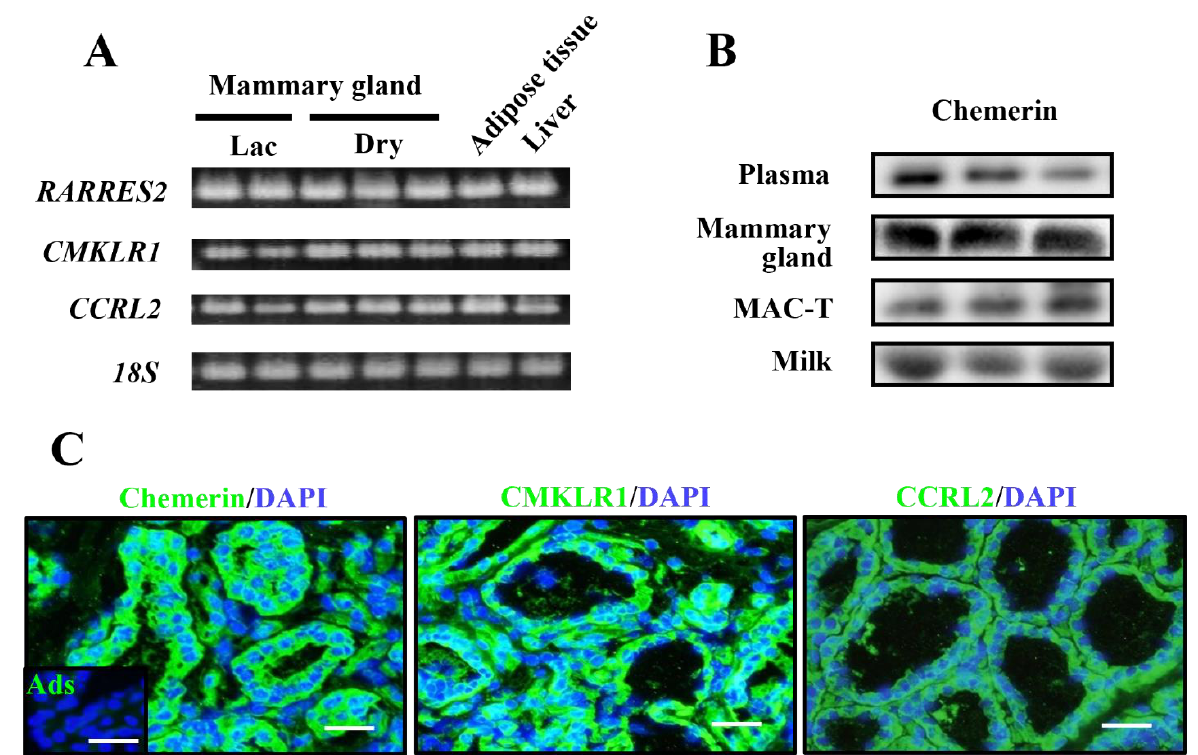
Figure 1. Expression and localization of chemerin and its receptors in the bovine mammary gland. Mammary gland tissues were collected from multiparous Holstein dairy cows at the lactation (Lac) and dry-off periods (Dry); n = 2 and 3, respectively. Gene expression of chemerin and its receptors were investigated by RT-PCR, whereas perirenal adipose tissue and the liver served as positive controls ( A ). Chemerin protein (approximately 18 kDa) was detected by immunoblotting in plasma and fresh milk from other lactating Holstein cows ( n = 3) ( B ). Chemerin or its receptor-expressing cells were visualized by immunostaining in frozen mammary gland sections from lactating Holstein cows; n = 3 ( C ). Control sections were treated with antigen-adsorbed anti-chemerin antibodies for immunostaining (Ads). Counterstaining was performed with 4',6-diamidino-2-phenylindole (DAPI). Scale bar = 50 μm.